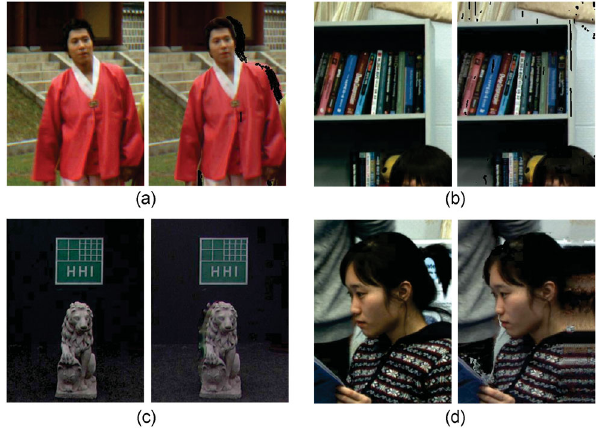
Fig. 1 Geometric distortions in DIBR synthetic images. In each pair, left: undistorted image, right: synthetic image. (a)–(d) exhibit holes , cracks , ghost artifacts , and stretching ,